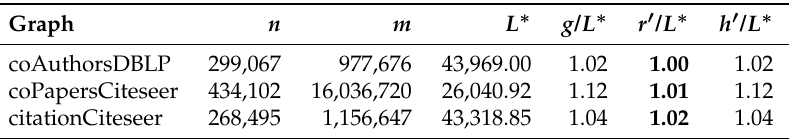
Table 8. Results for DIMACS Graphs.